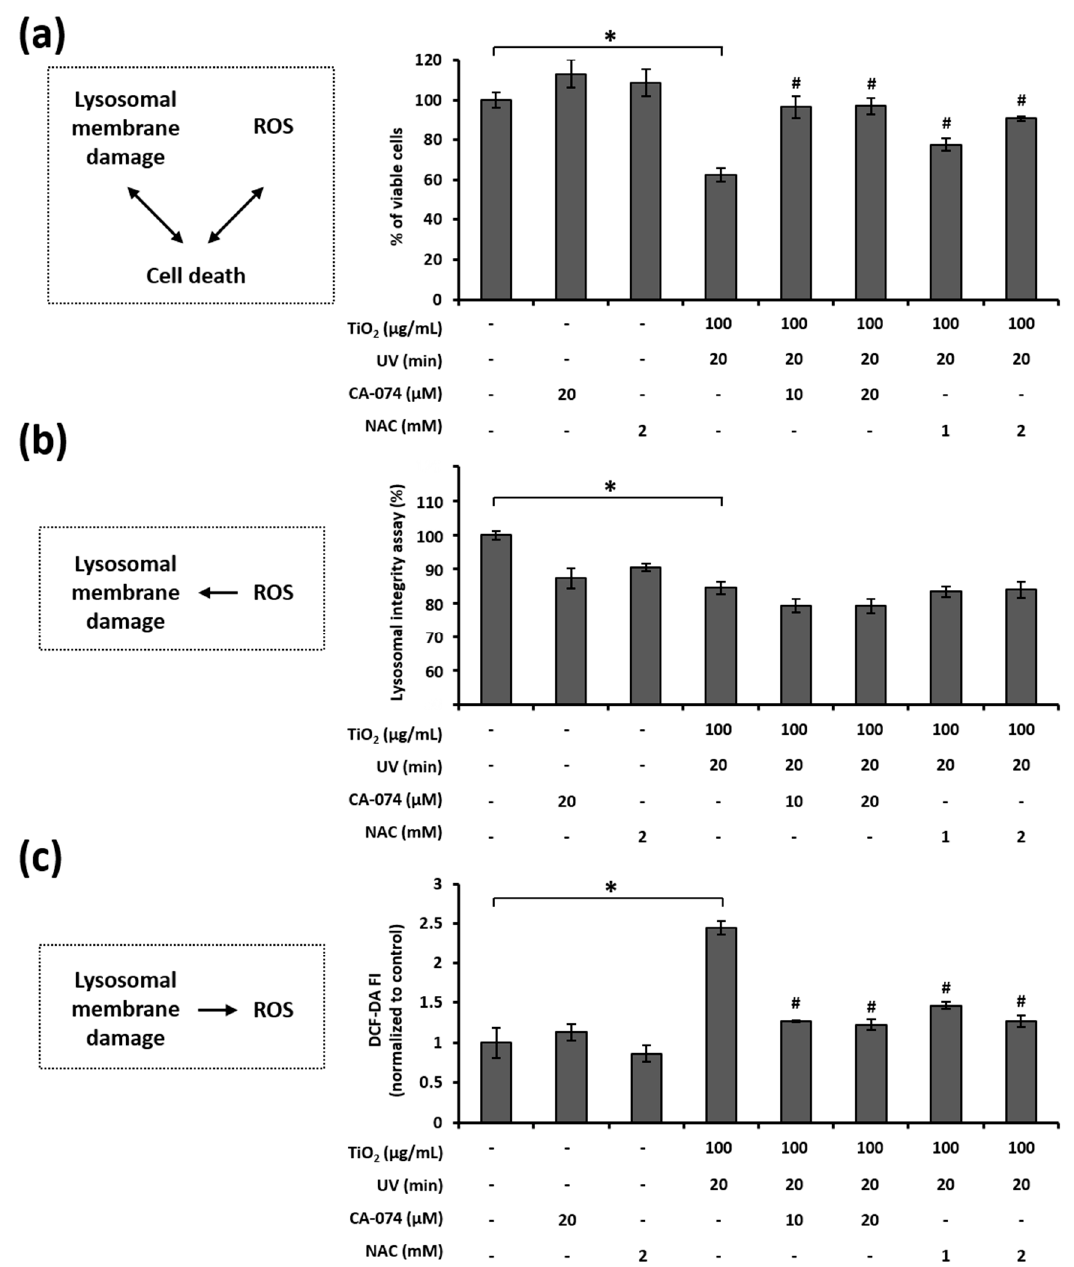
Figure 7. Interaction among cell death, LMP, and ROS in HaCaT cells treated with TiO 2 NPs and UVA: ( a ) the cells were treated with TiO 2 NPs for 24 h and subsequently irradiated with UVA for 20 min. HBSS was replaced with the complete medium containing CA-074 or NAC, and the cells were incubated for 24 h. Cellular viability was evaluated using the CellTiter-Glo ® Luminescent cell viability assay; ( b ) after AO staining, the cells were treated with TiO 2 NPs, UVA, and inhibitors for 8 h. The cells were then subjected to microplate reading; ( c ) the treated cells were stained with CM-H 2 DCF-DA. The cells were subjected to microplate reading. Data are presented as mean ± SD ( n = 8). * p < 0.05, compared with untreated cells; # p < 0.05, compared with the combination of TiO 2 NPs and UVA.